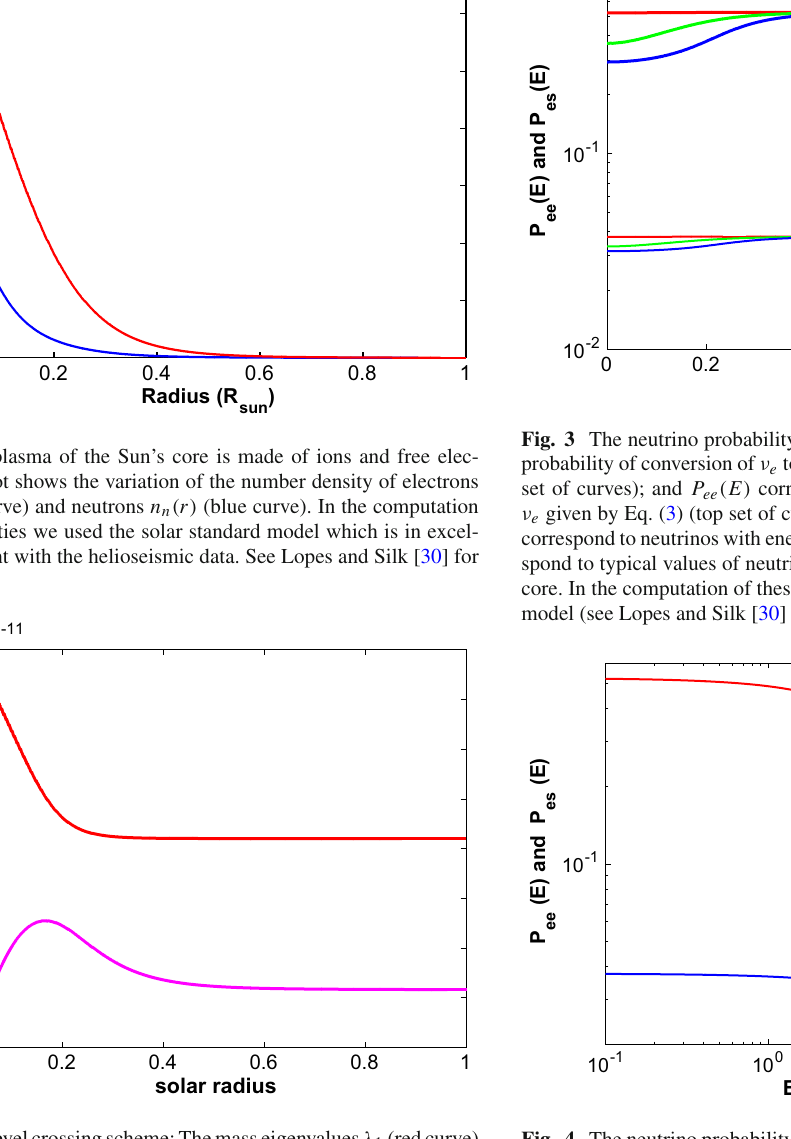
Fig. 4 The neutrino probability functions as a function of the neutrino energy: P es ( E ) corresponds to the probability of conversion of ν e to ν s neutrinos (blue curve); P ee ( E ) corresponds to the survival probability of ν e neutrinos (red curve). See Fig. 3 for